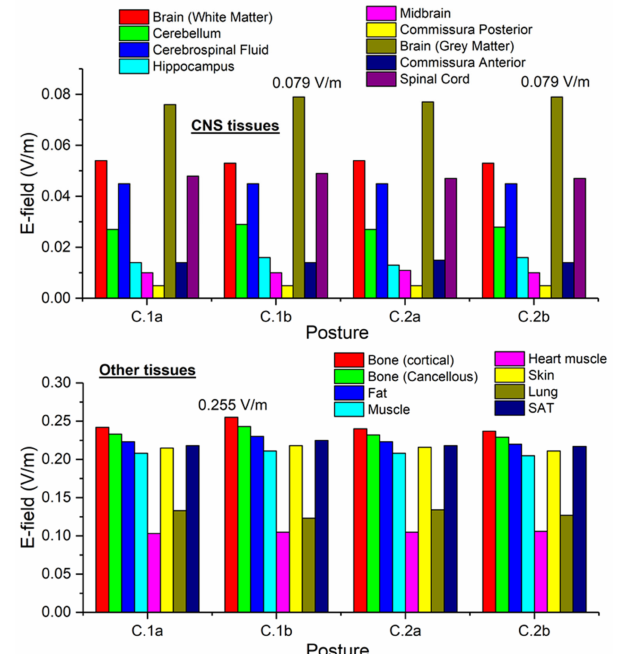
Figure 16. Exposure scenario C: on the upper diagram, maximum values of E-field (V / m) for the CNS tissues, on the bottom diagram, maximum values of E-field (V / m) for a selection of other